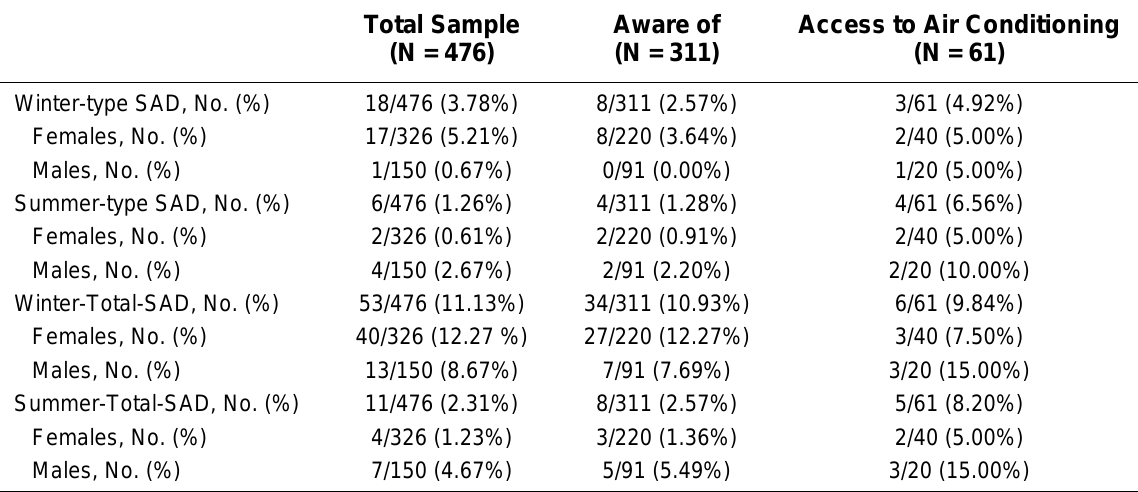
Prevalence Estimates for Winter- and Summer-type SAD and Total SAD, by Gender, Awareness, and Accessibility to Air Conditioning Systems